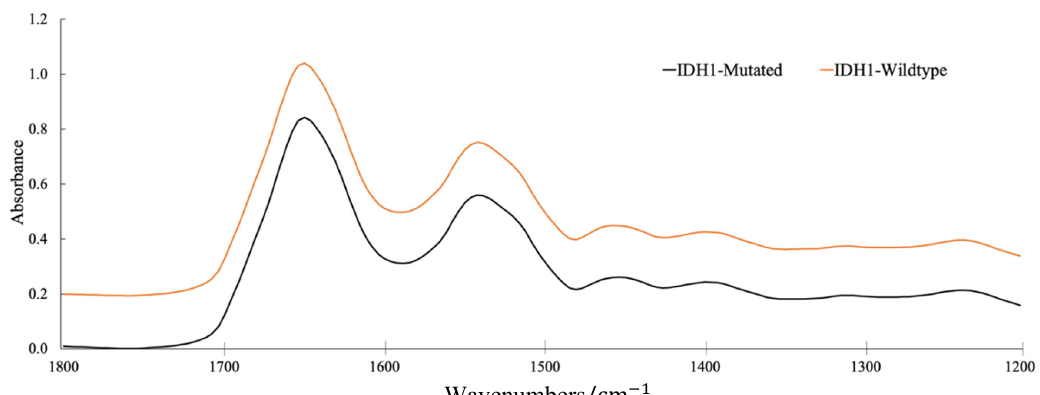
Wavenumbers /cm (cid:2879)(cid:2869) Figure 6. Mean pre-processed spectra for the synchrotron-based IDH1 dataset, cut between 1800 and 1200 cm − 1 . Spectra offset for clarity; mutated (black) and wildtype (orange).